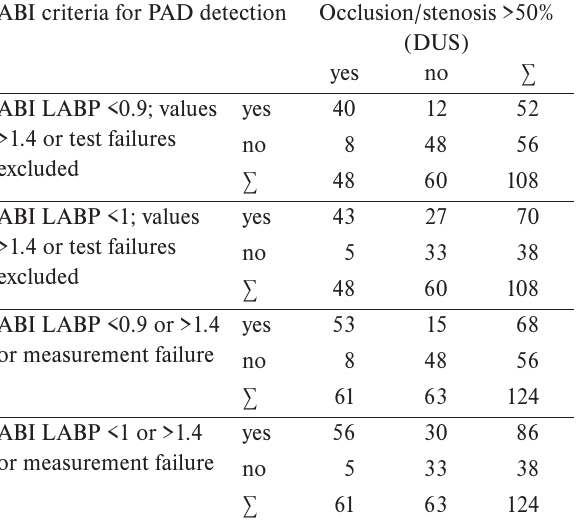
Table 3. Confusion matrices for individual variants of ABI LABP calculations.